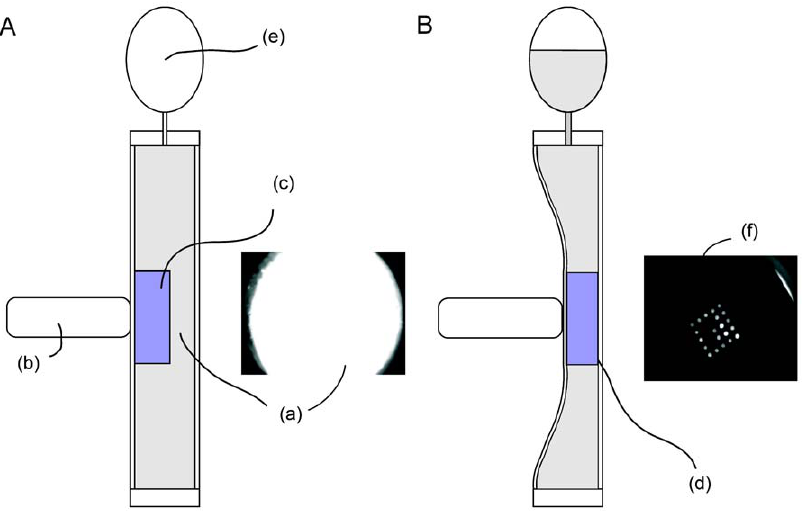
Figure 8. Schematic of the reaction chamber. The uncompressed reaction chamber is filled with the reaction mix containing a high concentration of fluorescently labeled reporter probes. Therefore, imaging of the hybridization pattern on the capture probe array against the background is not feasible ( a ). For image acquisition, pressure by means of a plunger ( b ) is applied and the array ( c ) is pressed tightly against the top side of the reaction chamber, thus displacing the fluorescent liquid ( d ). Displaced liquid is pressed into an integrated pneumatic spring ( e ). After image acquisition ( f ) the chamber is allowed to relax and the liquid mixture returns into the created volume.